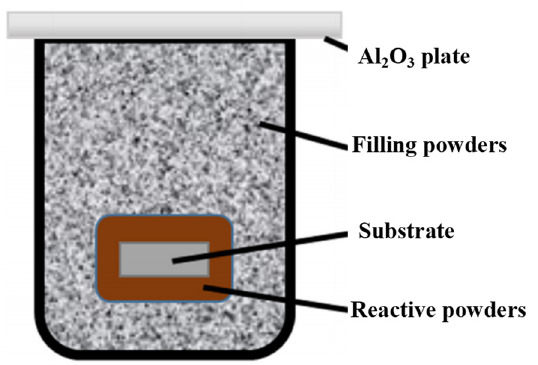
Figure 1. Schematic diagram of the reaction model of the HAPC method. Reprinted with permission from [29]; Reproduced from (Yang et al., 2018).